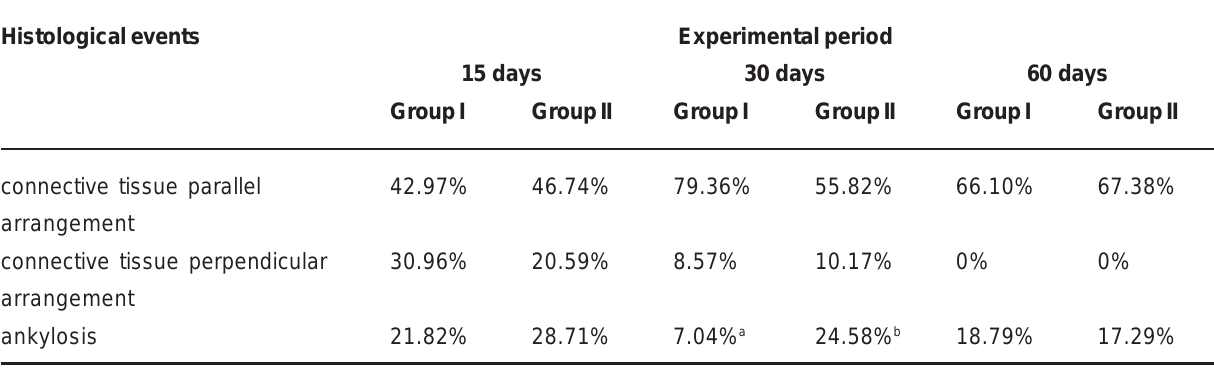
a is statistically significantly different from b (p<